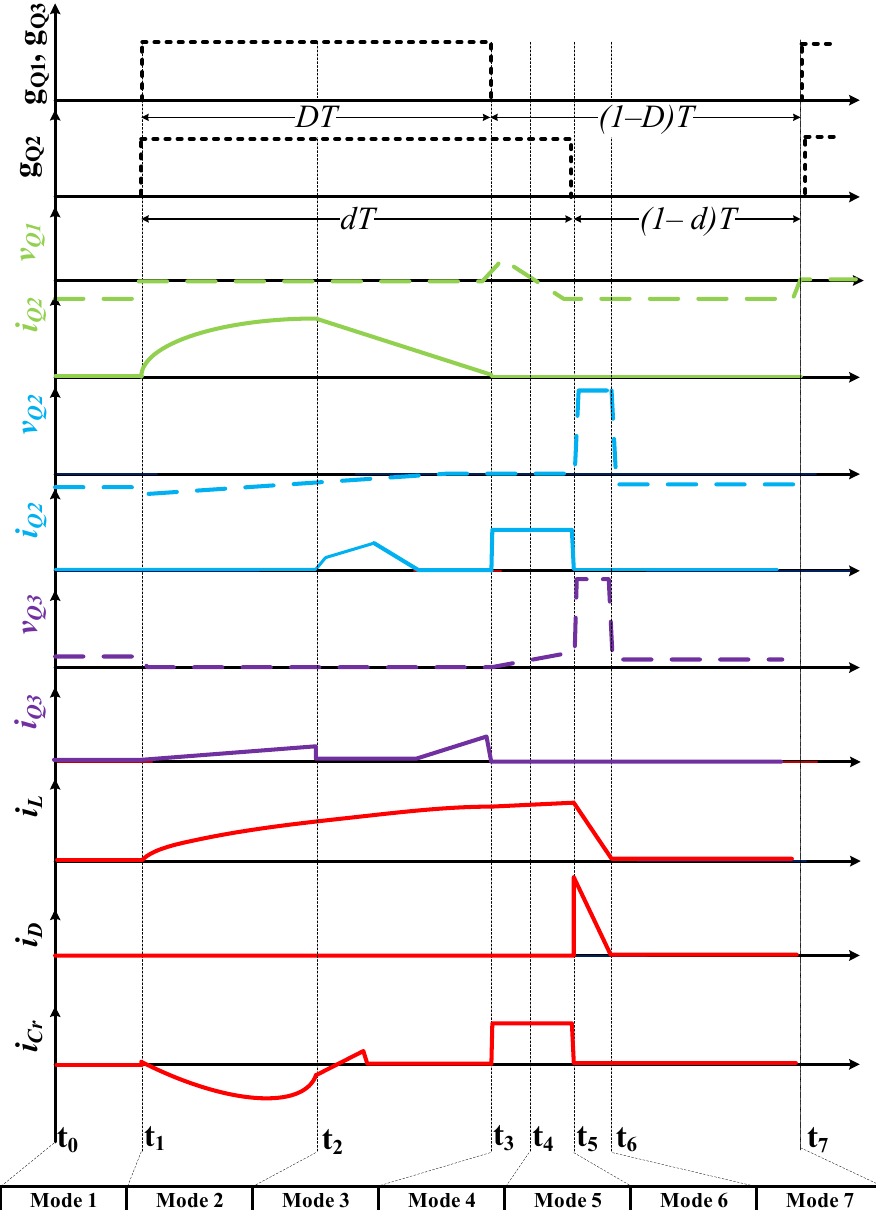
Figure 4. Selected waveforms of the converters in a switching period. The solid lines are used to represent the current waveforms of each component. The voltage waveforms are presented by the dashed lines. The gate pulses are shown by dotted lines. In this figure, g Q 1 , g Q 2 , and g Q 3 show the gate pulses of Q 1 , Q 2 , and Q 3 , respectively. The voltage and current of each switch are shown by v Qx , and i Qx where x is the switch number defined in Figure 2. The main inductor current, diode current ( D o ), and resonant capacitor current are shown by i L , i D , and i Cr , respectively. The L r current reaches zero at the end of this time interval. Then, t 3, as presented in (4), is calculated by means of the I Lr ( t ) equation from (3).